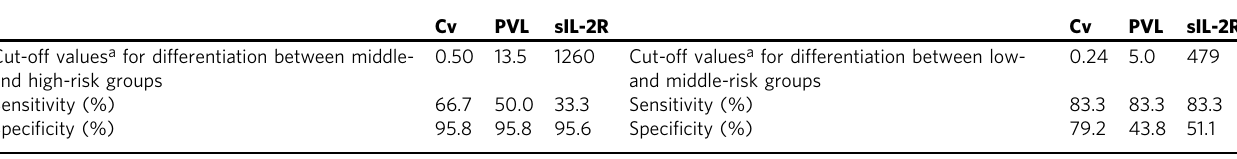
(Thermo Fisher Scienti fi c), and the analysis was performed on a 3730Xl DNA Analyzer (Thermo Fisher Scienti fi c). Development and application of CLOVA . We modi fi ed EditR 43 to develop CLOVA, an R program-based software that automatically enables analysis of the clonality value (Cv) of transgene-integrated cells, by uploading an “ ab.1 fi le, ” a